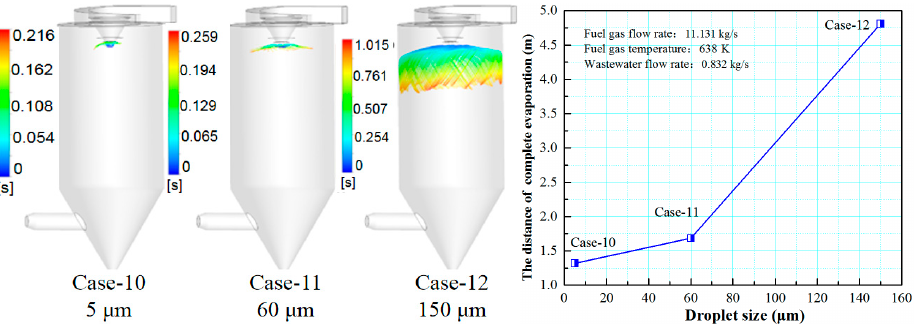
Figure 17. Temperature under different droplet sizes (K).